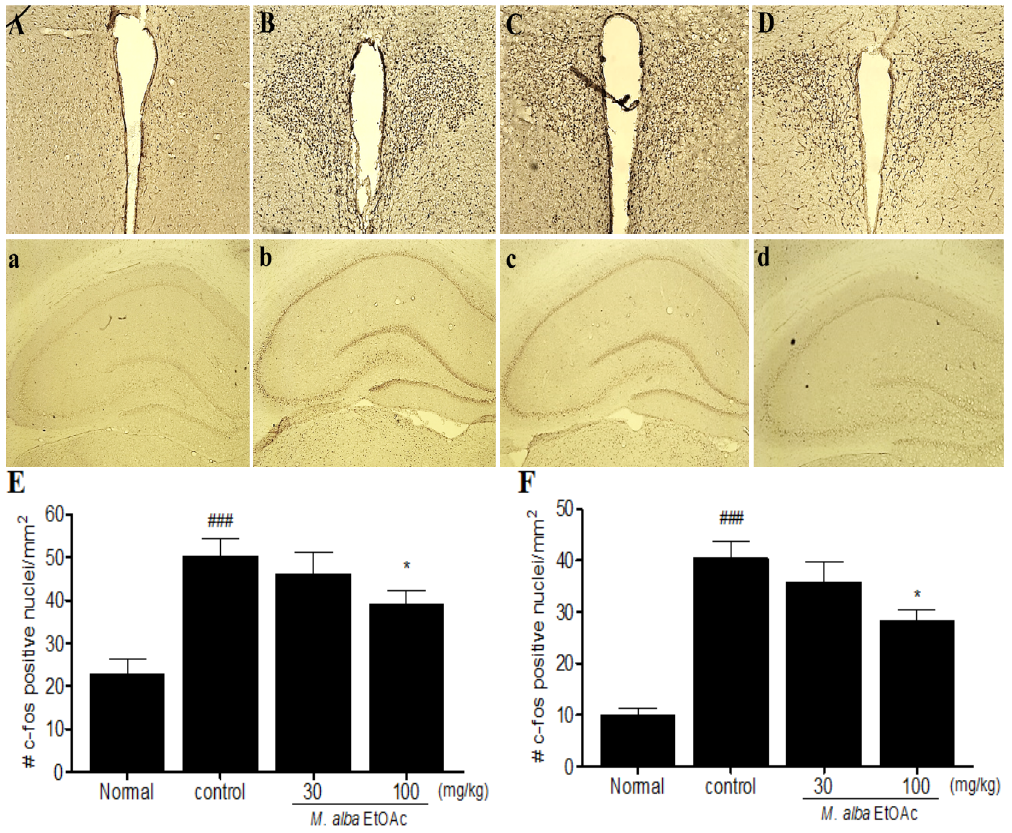
Figure 3. Effects of M. alba EtOAc fractions on c-fos expression in the hippocampus and PVN region. Representative photomicrographs are showing c-fos immunostained nuclei in the PVN of normal ( A ); control ( B ); M. alba EtOAc fraction 30 mg/kg ( C ); and M. alba EtOAc fraction 100 mg/kg ( D ); and in the hippocampus of normal (A); control (B); M. alba EtOAc fraction 30 mg/kg (C); and M. alba EtOAc fraction 100 mg/kg (D). Mean ± SEM values of c-fos immunostained nuclei in the hypothalamic PVN ( E ) and hippocampus ( F ). * p < 0.05, significantly different from the control group. ### p < 0.001, significantly different from the normal